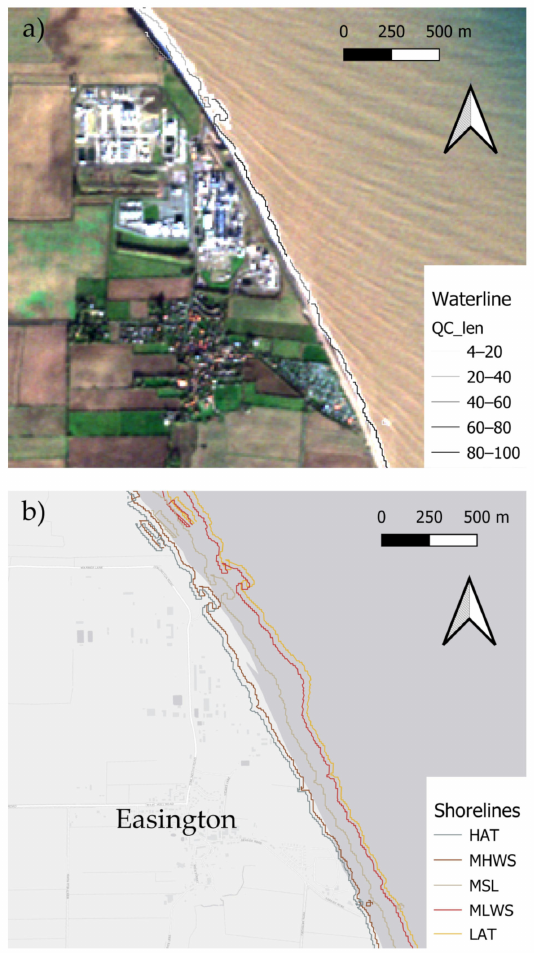
Figure 2. Examples of waterlines (WL) and shorelines (SL) derived from MSI imagery used in this study; ( a ) example of Waterline product produced for the East Riding of Yorkshire region over the S2 MSI image used to produce the WL. The WL is color coded using one of the quality flags metadata provided; ( b ) example of shorelines produced for the same area. The tidal levels shown are Mean Sea Level (MSL), Lowest Astronomical Tide (LAT) and Highest Astronomical Tide (HAT), Mean Low Water Springs (MLWS), Mean High Water Springs (MHWS). Source of satellite image: Sentinel-2 MSI images taken 3 December 2019 at 11:13 UTM. Copernicus Sentinel data 2019. Source of Light Gray Canvas Base map: Esri, HERE, Garmin, © OpenStreetMap contributors, and the GIS user